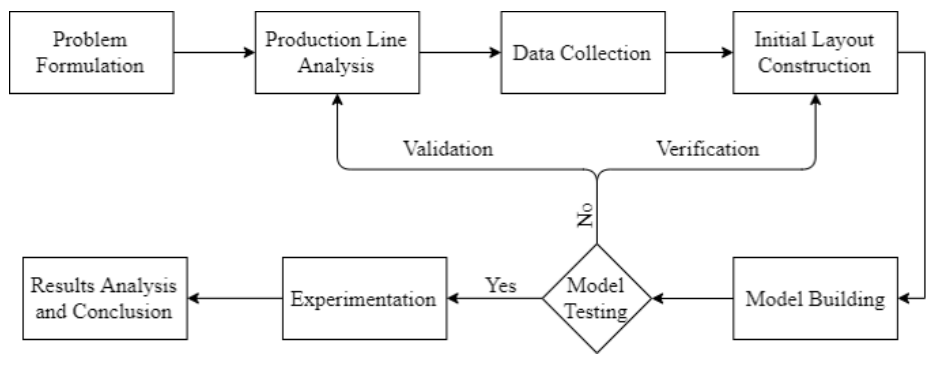
Figure 2. Proposed DES